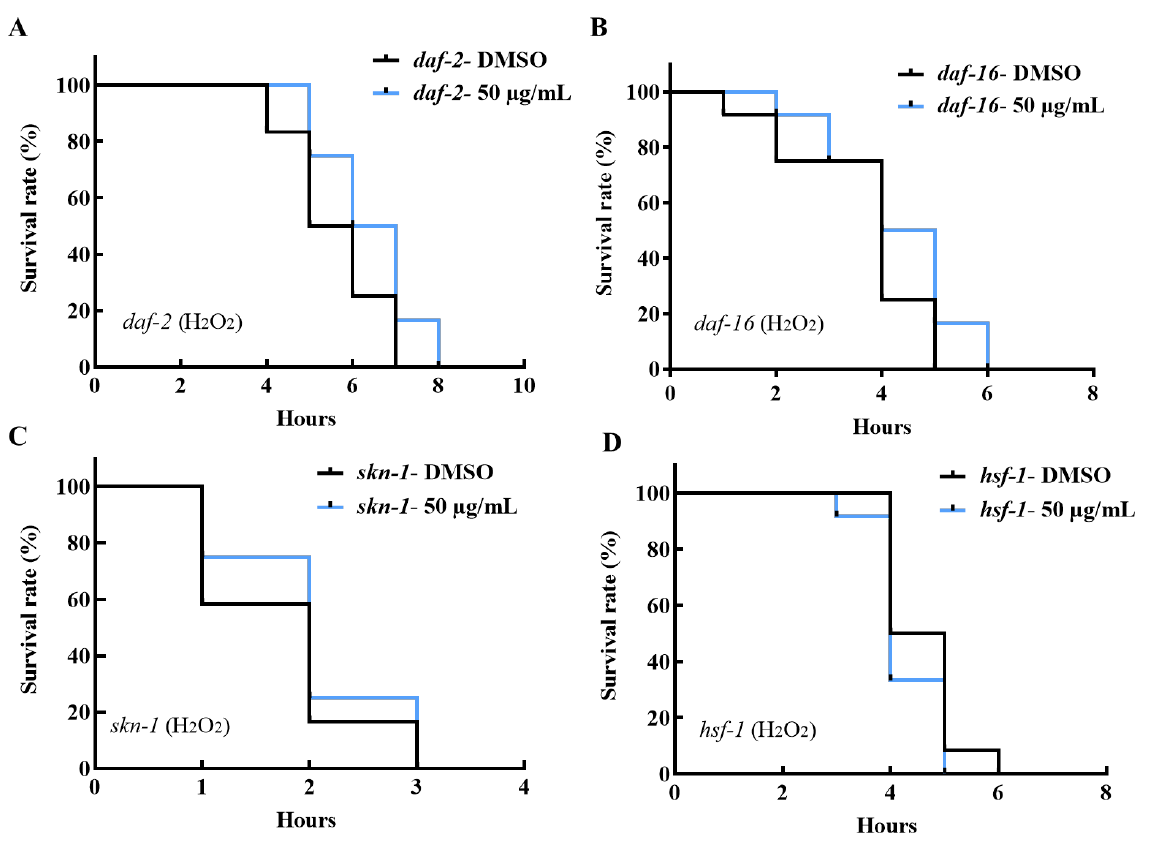
Figure 6. Effect of AE on the oxidative stress survival of C. elegans mutants. Worms were cultured at 20 °C on NGM-OP50 plates, treated with or without AE (50 µg/mL) for 96 h. ( A ) daf-2 ( e1370 ) mutants, ( B ) daf-16 ( mgDf50 ) mutants, ( C ) skn-1 ( tm4241 ) mutants and ( D ) hsf-1 ( sy441 ) mutants oxidative stress survival ( n = 12 worms/group). Statistical significances of survival curves were assessed by log-rank test. Experiments were performed in triplicate determinations and representative curves